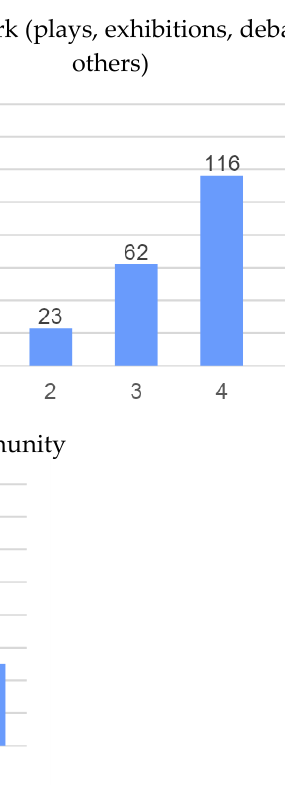
Figure 2. Methodologies used to learn social sciences. The data on the horizontal axis correspond to the five words that the participants associated with the didactics of social sciences.